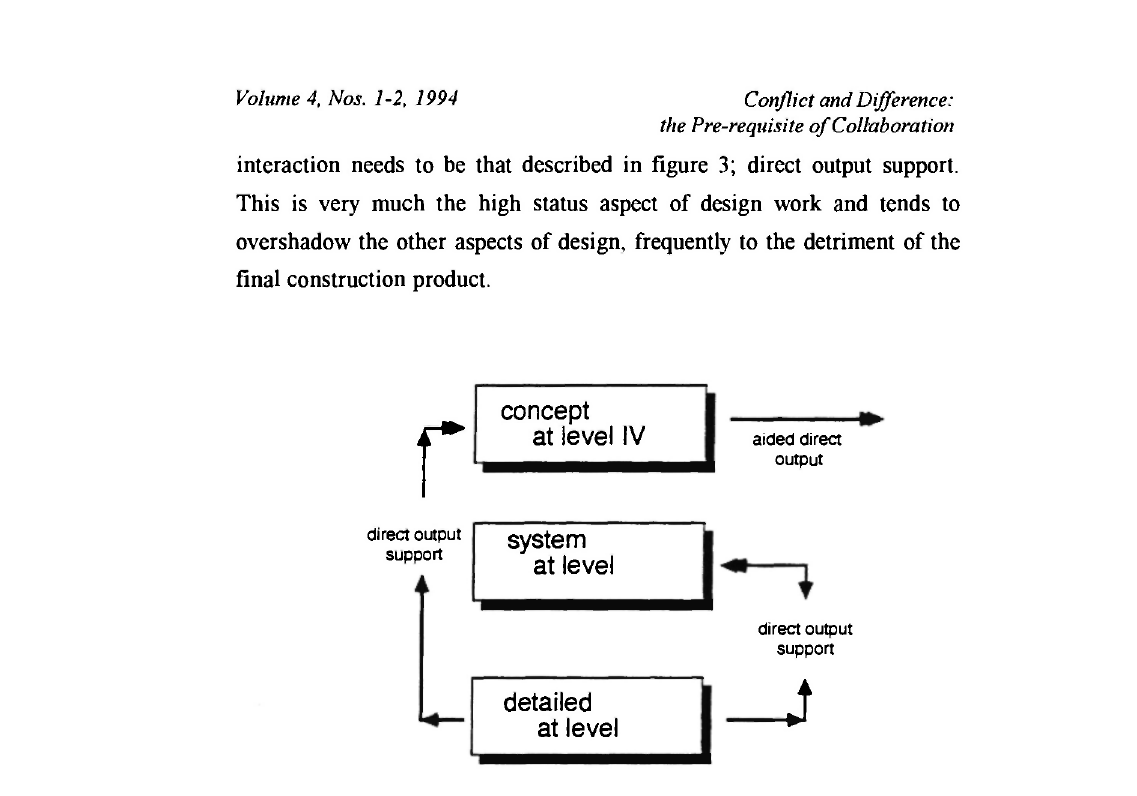
Fig. 3: Relationships involved in direct output